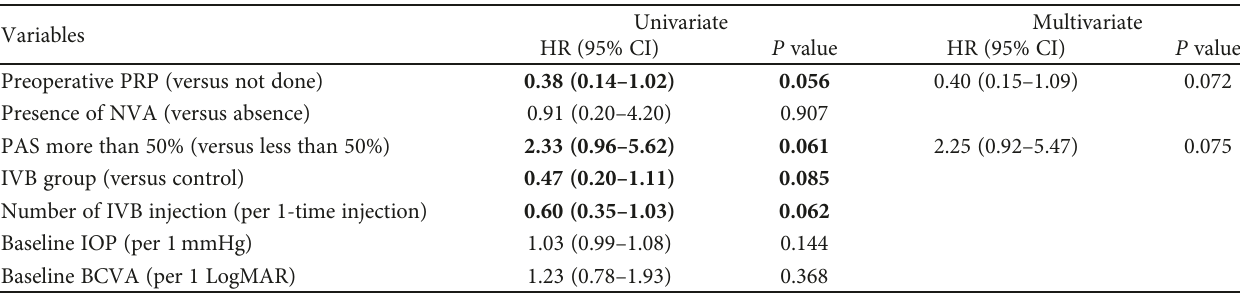
Table 4: Result of cox proportional hazard analysis for assessing risk factors of surgical failure (total of 70 eyes).